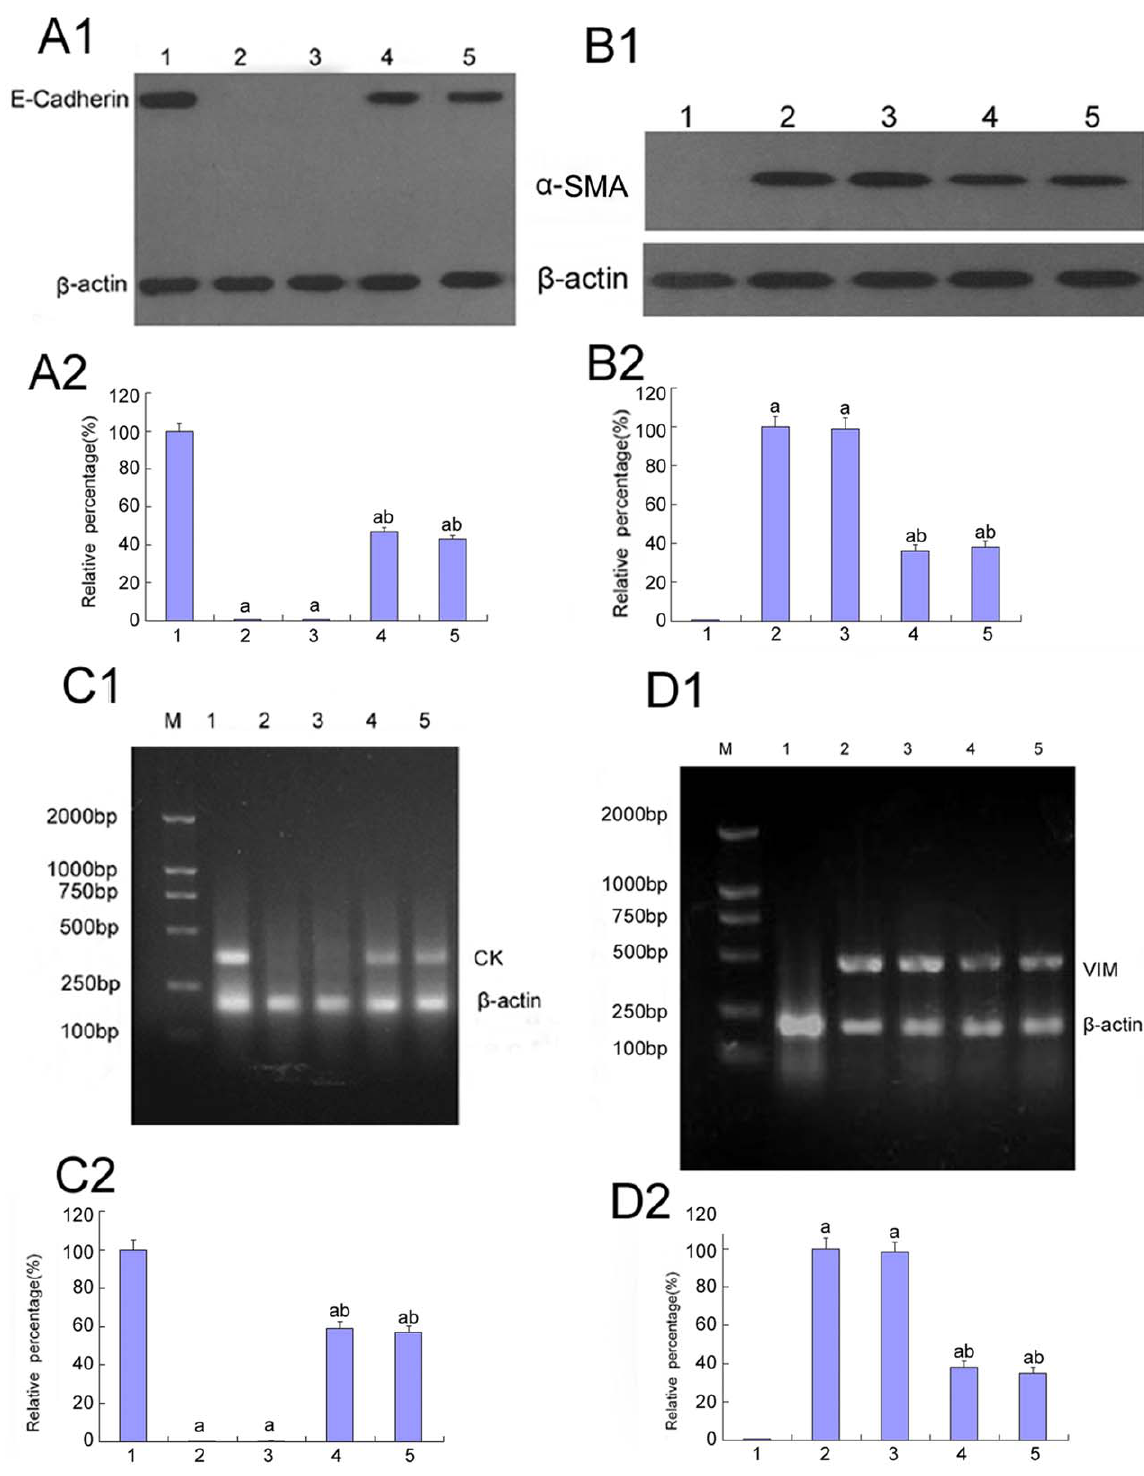
Figure 5. Expression of E-cadherin, CK, a -SMA, vimentin in HK-2 cells by Western blot and RT-PCR analysis. (A–B)E-cadherin expression(A1,A2) and a -SMA(B1,B2) were analyzed by Western blot of the HK-2 cells cultured in 5.5 mM glucose (lane 1), 30 mM glucose (lane 2), 30 mM glucose + Cont siRNA(lane 3), 30 mM glucose + p38 siRNA for 24 h(lane 4), 30 mM glucose + p38 siRNA for 48 h(lane 5).(C–D)mRNA of CK (C1,C2) and vimentin(D1,D2) were analyzed by RT-PCR of the HK-2 cells cultured in 5.5 mM glucose (lane 1), 30 mM glucose (lane 2), 30 mM glucose + Cont siRNA(lane 3), 30 mM glucose + p38 siRNA for 24 h(lane 4), 30 mM glucose + p38 siRNA for 48 h(lane 5).Values represent the mean 6 SD, a P , 0.05 vs. 5.5 mM glucose, b P , 0.05 vs. 30 mM glucose.